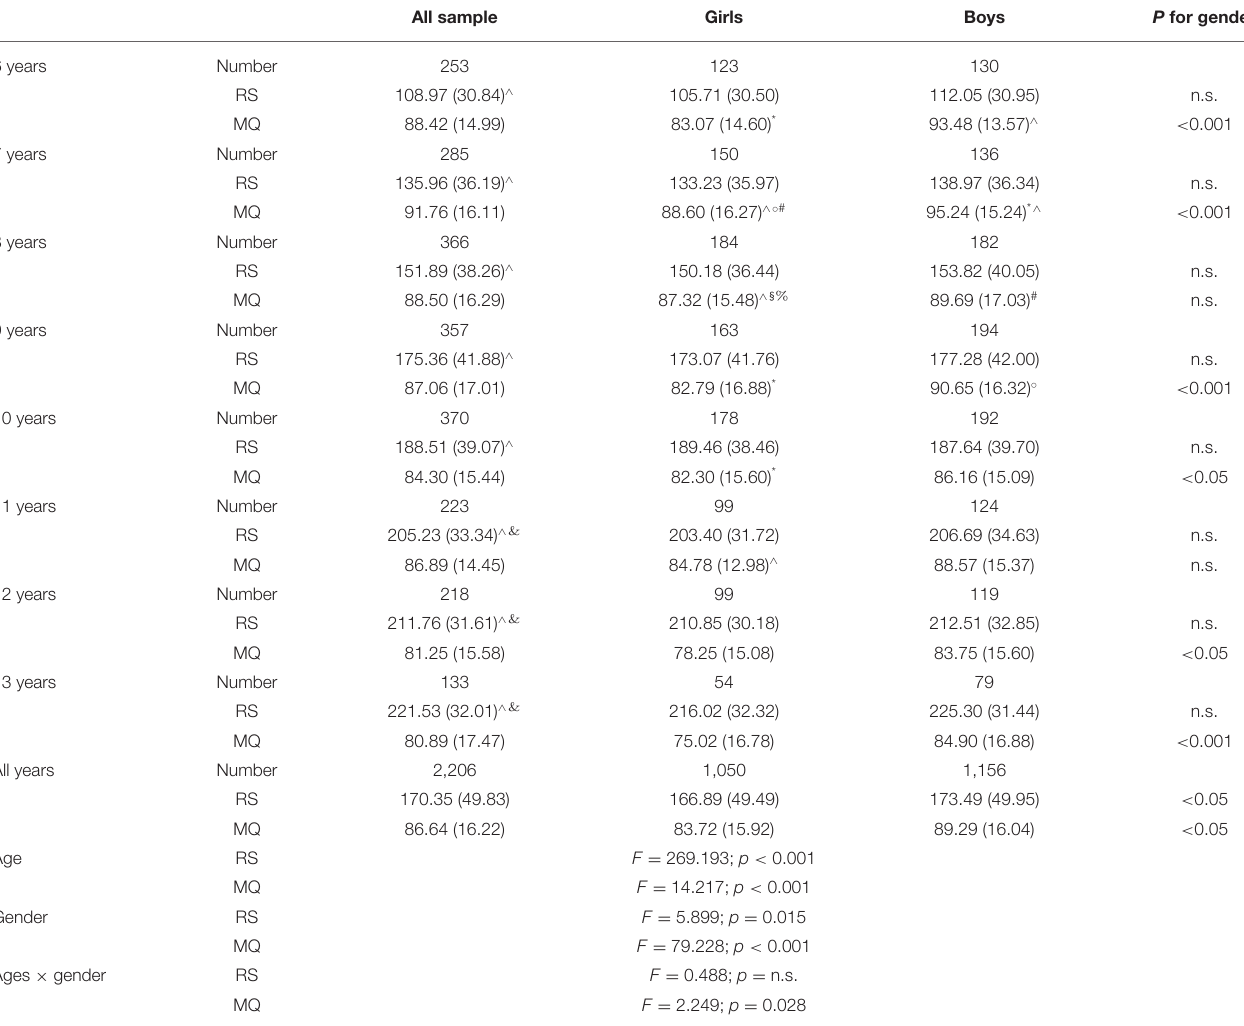
TABLE 1 | Number of subjects, mean values of raw score (RS), and motor quotient (MQ) by gender and age. All sample